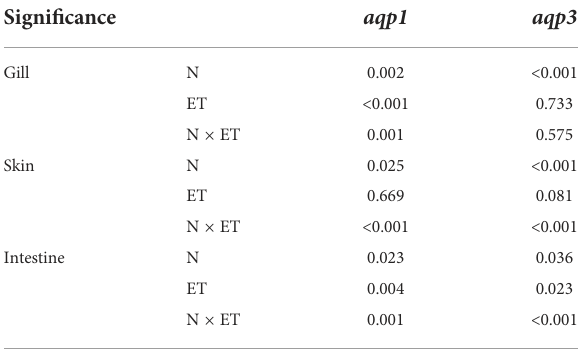
TABLE 2 Two-way ANOVA P value in an ammonia exposure trial. Signi fi